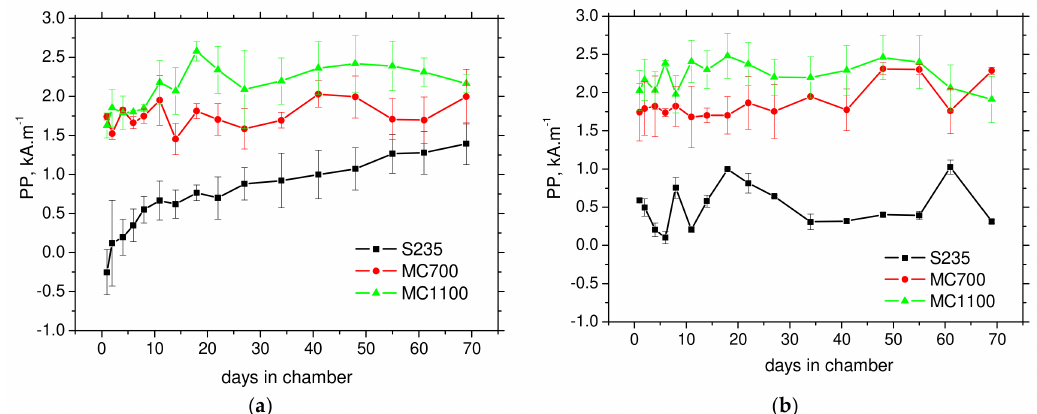
Figure 8. Evolution of PP along the days in the chamber. ( a ) RD, ( b ) TD.